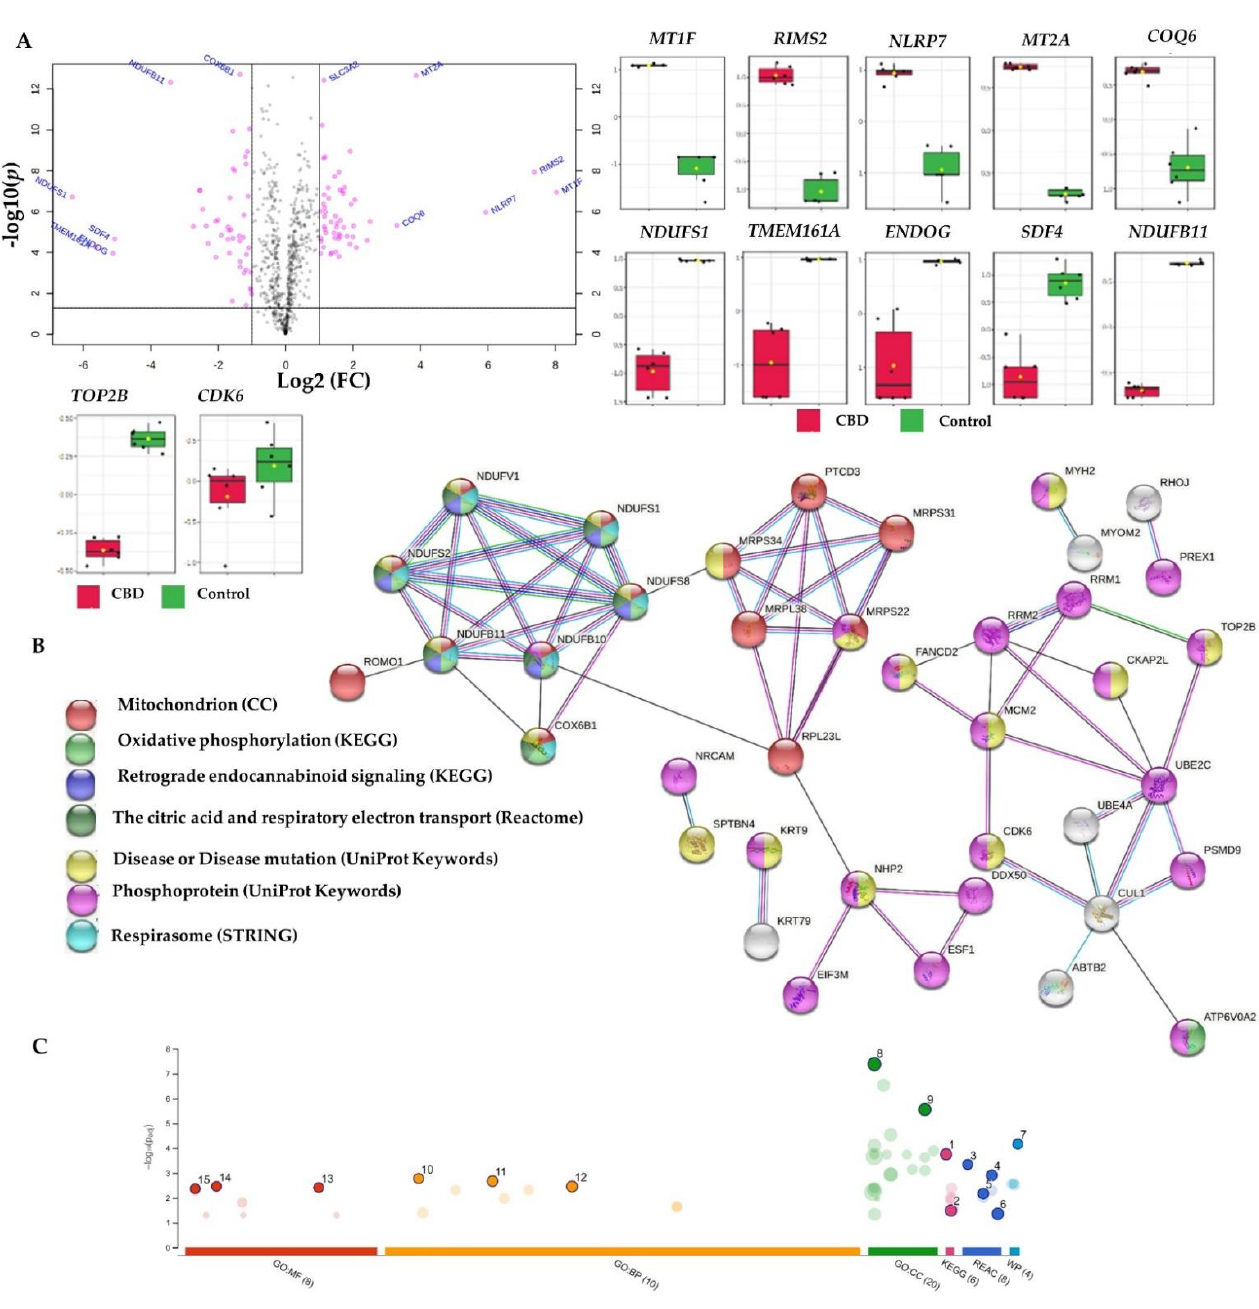
Figure 7. Differentially expressed proteins in cannabidiol (CBD)-treated MCF7 cells compared to controls, and the corresponding overrepresented pathways. ( A ) Volcano plot with an absolute log2 fold change ≥ 1 and p -value ≤ 0.05 cutoff, for the identified proteins in CBD-treated cells, together with selected proteins’ expression summary compared to the controls. ( B ) STRING network of the 121 differentially expressed proteins (fold change ≥ 2; p and Q values ≤ 0.01) in the cannabidiol-treated MCF7 cells compared to the controls. The minimum required interaction score was 0.40 (medium confidence), and red, green, blue, purple, light blue, and black interaction lines indicate the presence of fusion, neighbourhood, co-occurrence, experimental, database, and co-expression evidence, respectively. The disconnected nodes were hidden in the network. ( C ) Overrepresented pathways using g:Profiler for the differentially expressed proteins (fold change ≥ 2; p and Q values ≤ 0.01) in the cannabidiol-treated MCF7 cells compared to the controls (1 = oxidative phosphorylation; 2 = ret- rograde endocannabinoid signalling; 3 = complex I biogenesis; 4 = respiratory electron transport; 5 = mitochondrial translation initiation; 6 = the citric acid (TCA) cycle and respiratory electron transport; 7 = mitochondrial complex I assembly model OXPHOS system; 8 = mitochondrial inner membrane; 9 = mito- chondrial protein-containing complex; 10 = mitochondrial electron transport; NADH to ubiquinone; 11 = aerobic electron transport chain; 12 = mitochondrial ATP synthesis-coupled electron transport; 13 = NADH dehydrogenase (quinone) activity; 14 = NADH dehydrogenase (ubiquinone) activity; 15 = NADH dehydrogenase activity). CC: cellular components; MF: molecular function; BP: biological processes; REAC: Reactome database; WP: Wiki Pathways.